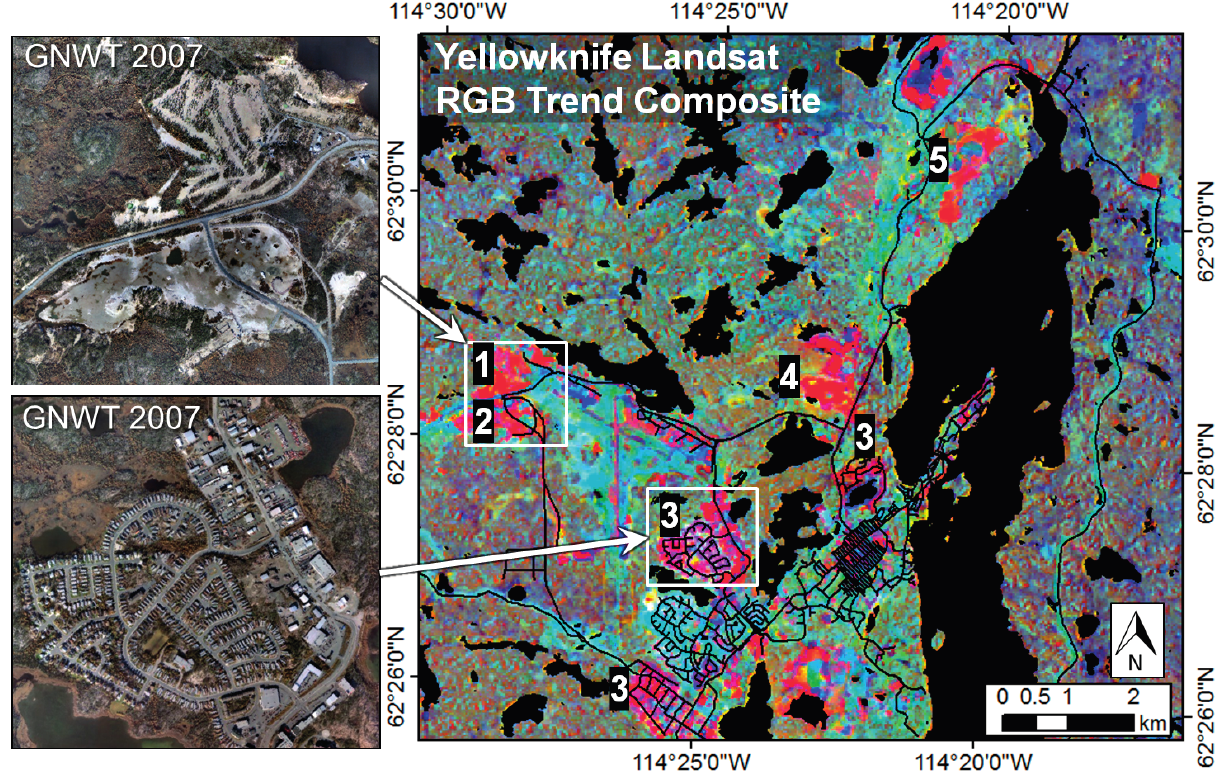
Figure 13. Air photos acquired by the NWT Government in 2007 ( left ) showing land use changes visible in the TC trend image for the city of Yellowknife ( right ). These changes relate to post-1985 development (red) and regeneration of previously disturbed areas (teal) and include the construction of a golf course (1), a gravy quarry (2), new housing subdivisions (3), a solid waste facility (4), and open mining pits